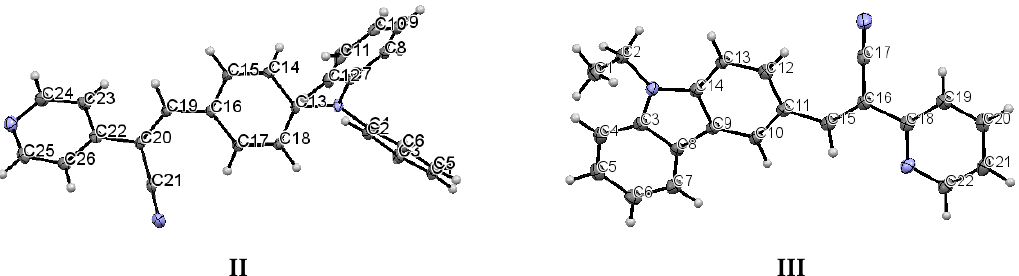
Figure 5. Displacement ellipsoid plots (50% probability level) II and III . Both compounds have anti conformation.